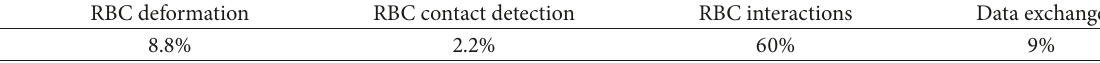
Table 1: CPU usage for different parts of the coupled solver.